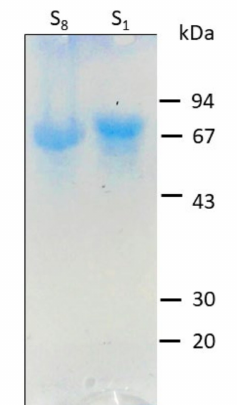
Figure 1. Sodium dodecyl sulphate-polyacrylamide gel electrophoresis (SDS-PAGE) of L. kefiri CIDCA 83,111 (S 1 ) and CIDCA 8348 (S 8 ). Molecular mass markers are shown on the right (kDa).